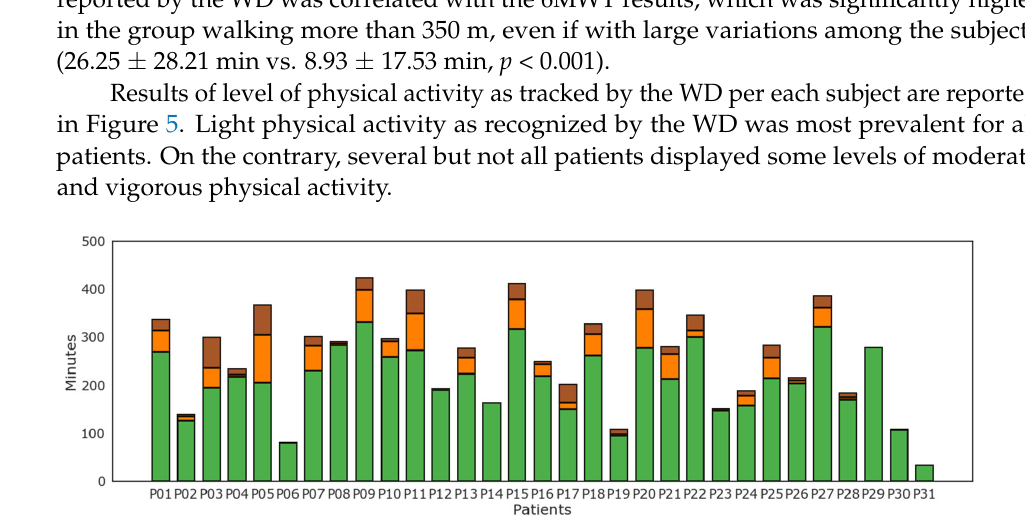
Figure 6. Correlation between 6 ‐ minute walking test results and maximal oxygen consumption (VO2max) as calculated and reported by wearable devices. The HR measured by the device’s sensor showed a significant variability among pa ‐ tients, and no correlation. Several patients reached a HR greater than 160 bpm, while oth ‐ ers rarely surpassed 120 bpm. The recovery HR has been normalized and correlated to the distance walked during the 6MWT and showed an intermediate correlation (r = 0.45). Two patients out of thirty ‐ one did not undergo surgery due to a change in the surgi ‐ cal plan after enrollment and anesthesiologic evaluation. There was a low number of